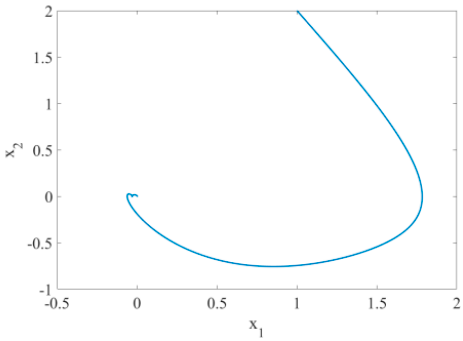
Mathematics 2020 , 8 , x FOR PEER REVIEW 12 of 14 Figure 15. Phase diagram of system with unknown parameters (with disturbance,